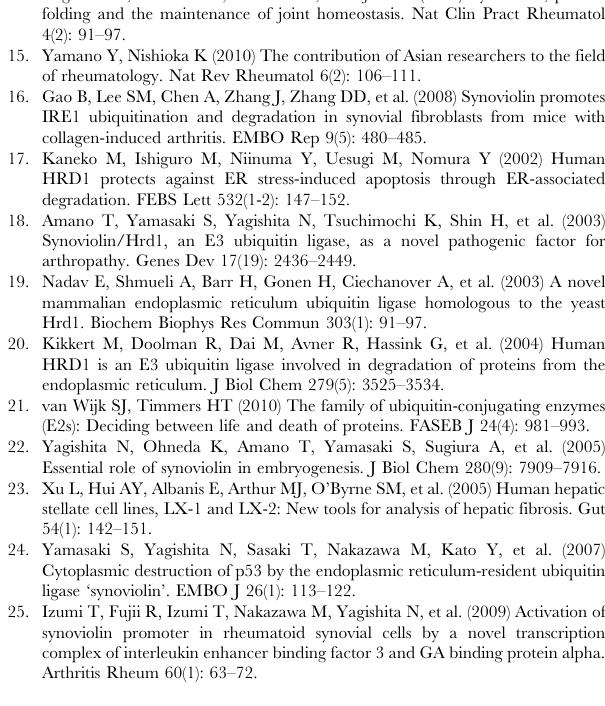
Figure S5 The expression and localization of the laminin protein in wt and Syno 2 / 2 MEFs. (A) Effect of synoviolin on the expression of laminin. The amount of laminin in whole cell lysates of wt and Syno 2 / 2 MEFs was analyzed by immunoblot analysis using anti-laminin, synoviolin, and b -actin antibodies. The antibodies used in this study were as follows: anti-laminin polyclonal antibody (Sigma). The results were derived from 3 independent experiments. (B) Double immunofluorescence stain- ing was performed using antibodies against laminin and GM130 or PDI. Fluorescent images were visualized using a Zeiss LSM 510 META confocal fluorescence microscope (Carl Zeiss, Jena, Germany). The results were derived from 3 independent experiments. Scale bar = 20 m